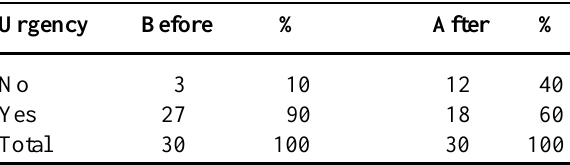
Table 2 – Resiniferatoxin effect on urgency.